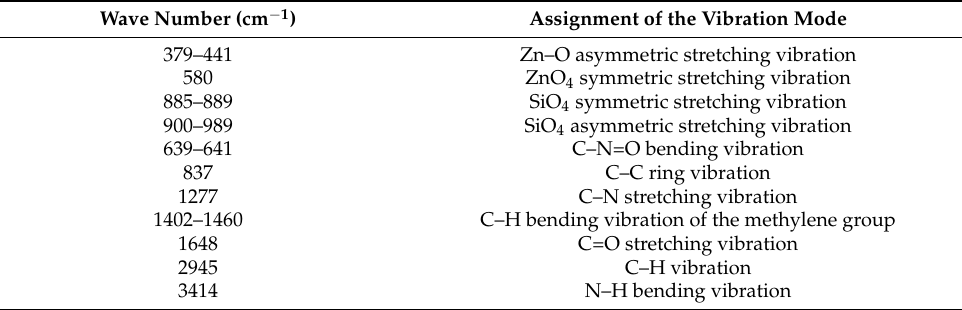
Figure 5. ( a ) FT–IR spectra of willemite NPs calcined different temperature; ( b ) FT–IR patterns of willemite with different Ce 3+ doping concentrations calcined at 900 °C. Table 2. FT–IR absorption bands and their corresponding assignments.